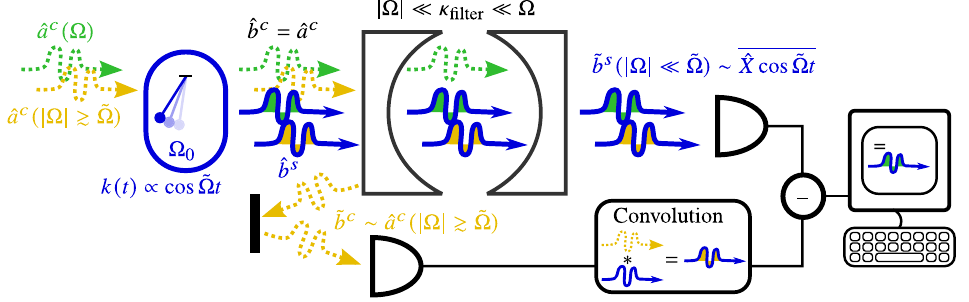
FIG. 4. Scheme for removing extraneous QBA (27) by invoking an auxiliary measurement channel and postprocessing. Spectral ˆ separation of the output light field b from the oscillator is performed using an external narrowband cavity ( | (cid:2) | (cid:8) κ filter (cid:8) ˜ (cid:2) ) resonant ˆ at the optical carrier frequency ω filter = ω o . The resulting reflection of the high-frequency sideband components | (cid:2) | (cid:11) κ filter of b ((cid:2)) (absolute frequencies ω o ± (cid:2) ) permits a direct measurement of the stochastic, extraneous QBA force, arising from components | (cid:2) | (cid:3) ˜ ˜ (cid:2) (cid:11) κ b c ((cid:2)) = ˆ a c ((cid:2)) [in the particular case of two-tone driving, the relevant filter (yellow dashed arrow) of the amplitude quadrature ˆ components are (cid:2) ∼ ± 2 ˜ (cid:2) ; see Eq. (36)]. The transmitted, low-frequency sideband components | (cid:2) | (cid:8) κ filter (cid:8) ˜ (cid:2) of b s ((cid:2)) (blue ˆ ˜ thick arrows), Eq. (25), are subjected to a standard phase quadrature measurement b s ((cid:2)) . By postprocessing the auxiliary b s ((cid:2)) = ˜ ˜ measurement current b c according to the oscillator response function in Eq. (27) and subtraction from that of b s , the extraneous QBA contribution (blue arrow with yellow filling) is removed from the latter, resulting in an effective oscillator readout of the desired form, Eq. (24), containing only the nominal QBA contribution (blue arrow with green filling) induced by ˆ a c ((cid:2)) (green dashed